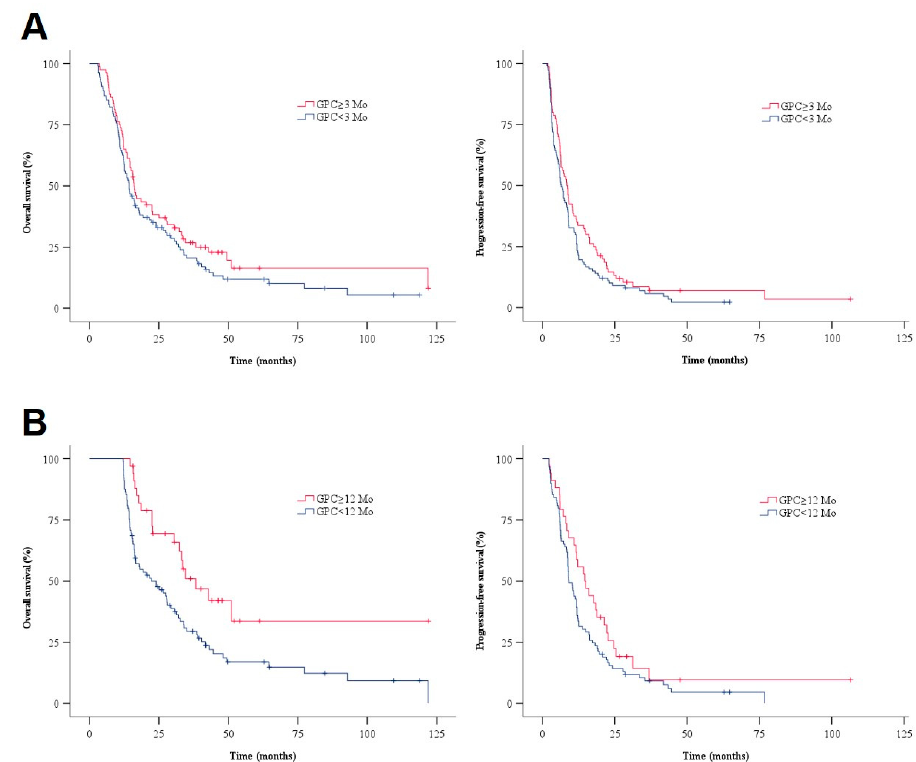
Figure 1. OS and PFS in the enrolled patients. ( A ) Kaplan–Meier survival curves showing the OS and PFS of patients according to the GPC use in all patients ( n = 187). The median OS was 16.1 months in the group that used GPC (usage duration ≥ 3 mos, n = 80) and 14.2 months in the group that did not (usage duration <3 mos, n = 107) ( p = 0.158). Median PFS was 8.4 months in the GPC group and 6.5 months in non-GPC group ( p = 0.092). ( B ) Kaplan–Meier survival curves showing the OS and PFS of patients, according to the long-term use of GPC in patients followed for more than 12 months after initial diagnosis ( n = 123). Median OS was 38.3 months in the long-term GPC group (usage duration ≥ 12 mos, n = 34) and 24.0 months in the non-long term GPC group (usage duration <12 mos, n = 89) ( p = 0.004). The median PFS was 14.6 months in the long-term GPC group and 9.1 months in the non-long term GPC group ( p = 0.082). (GPC, choline alphoscerate; OS, overall survival; PFS, progression-free